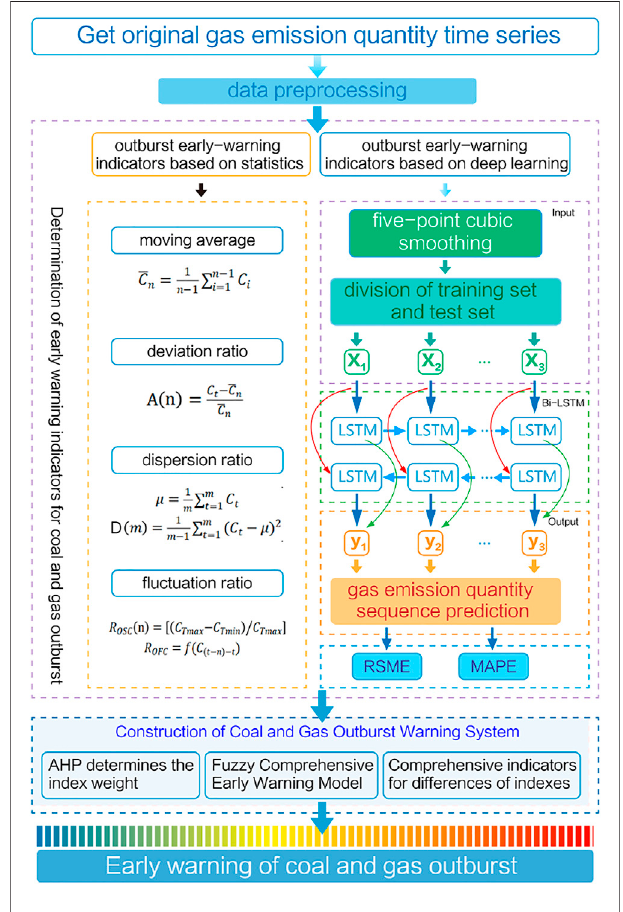
FIGURE 4 | Construction of coal and gas outburst early warning